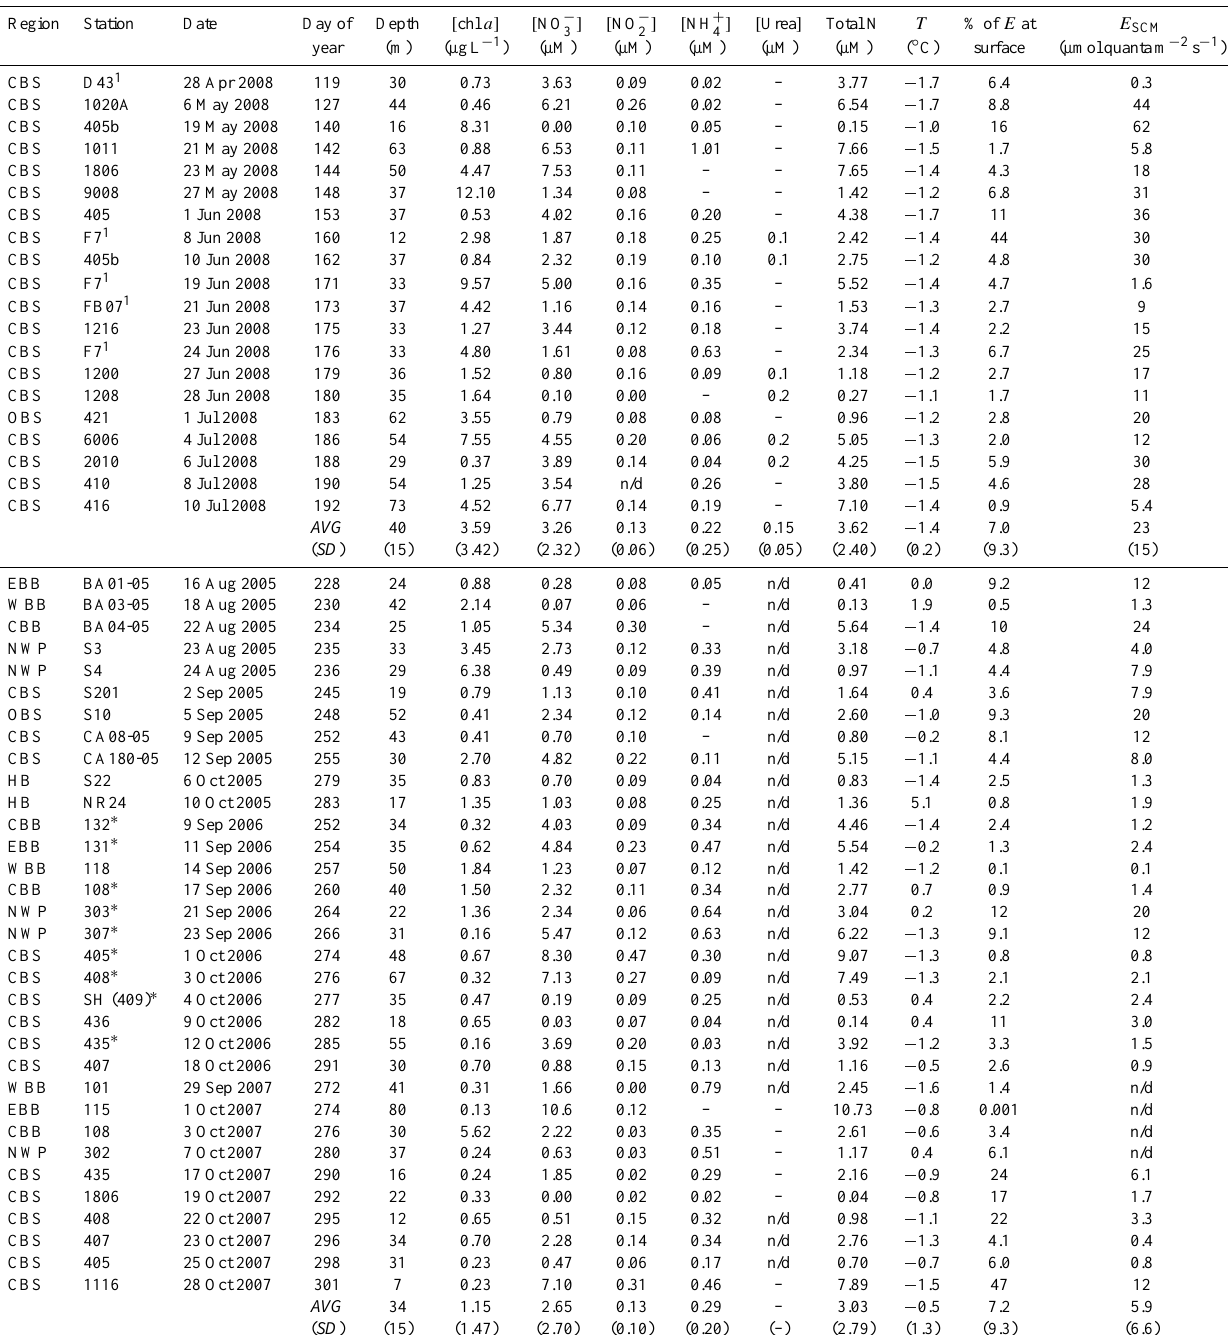
Table 1. Characteristics of the SCM at experimental stations located in the coastal Beaufort Sea (CBS), offshore Beaufort Sea (OBS), Northwest Passage (NWP), western, central and eastern Baffin Bay (WBB, CBB and EBB, respectively) and Hudson Bay (HB) for spring– early summer and late summer–fall. Stations where incubations were also performed with surface samples are marked with an asterisk ( ∗ ), “n/d” indicates that no data were available and “–” stands for values below the limit of detection. Averages (AVG) and standard deviations (SD) are presented for each